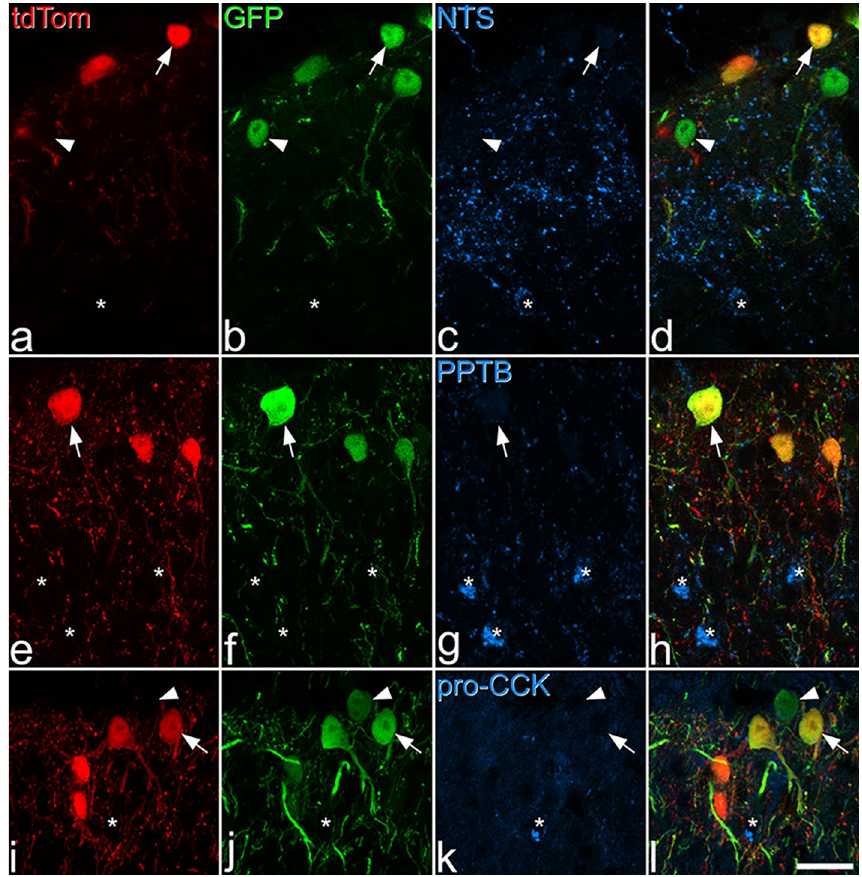
Figure 5. Lack of expression of neuropeptides associated with certain excitatory interneuron populations by NPFF-Cre neurons. Sections from NPFF Cre ;Ai9 mice that had been injected with AAV.flex.GFP were reacted with antibodies against neurotensin (NTS) ( a )–( d ), preprotachykinin B (PPTB) ( e )–( h ), or pro-CCK ( i )–( l ). Some cells that express both tdTomato and GFP are indicated with arrows, and some that only contain GFP with arrowheads. Cells that are immunoreactive for each of the peptide antibodies are indicated with asterisks. Note that staining for these peptides is located within the perikaryal cytoplasm of labelled neurons, and that there is no overlap with cells containing the fluorescent proteins. A few tdTomato-positive/GFP-negative cells were immunoreactive for neurotensin (1.3%) or pro-CCK (2.3%), whereas none contained PPTB. None of the GFP cells were immunroeactive for any of these (pro)peptides. Images are projections of 3 ( a – h ) or 5 ( i – l ) optical sections at 1 μm z-spacing. Scale bar = 20